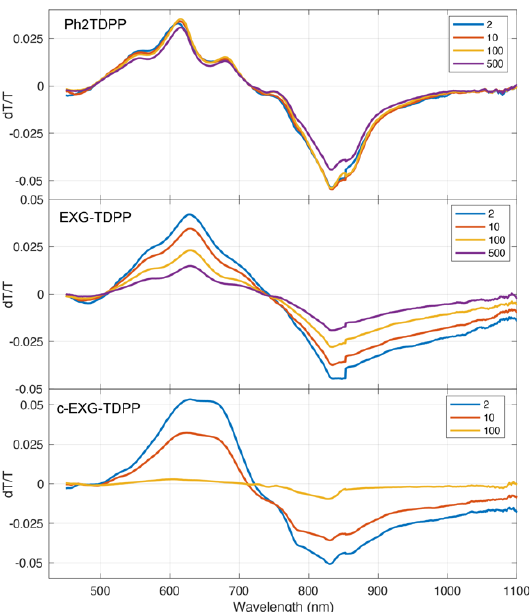
Figure 2: Transient absorption spectra for Ph 2 TDPP, EXG- TDPP, and c-EXG-TDPP at selected pump-probe delay times (labeled in picoseconds in legend). Discontinuity at ~850 nm is due to stitching between different experimental